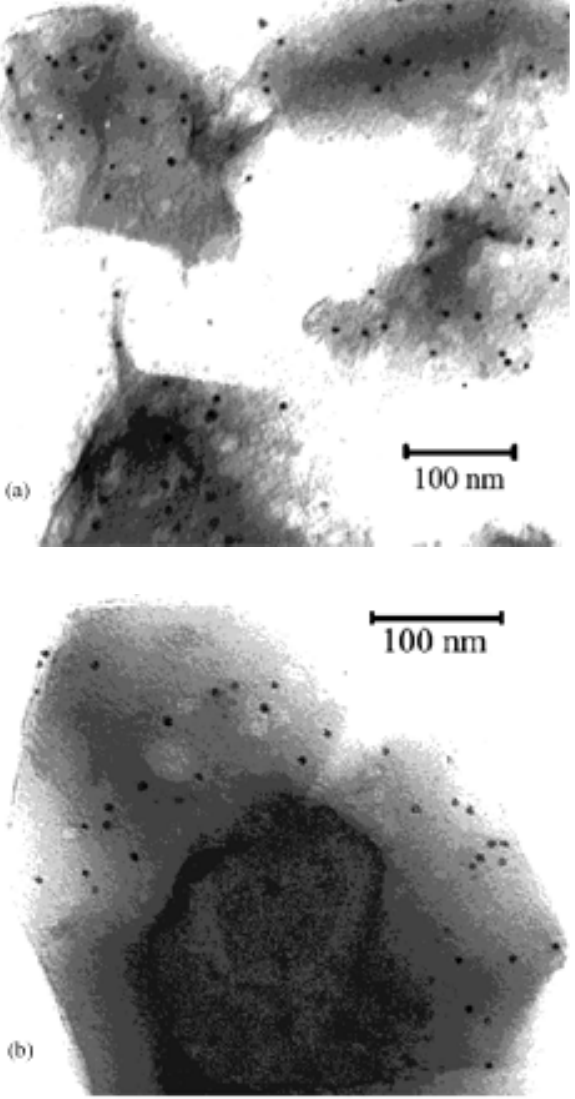
Figure 2. (a) and (b), TEM of samples B and C,